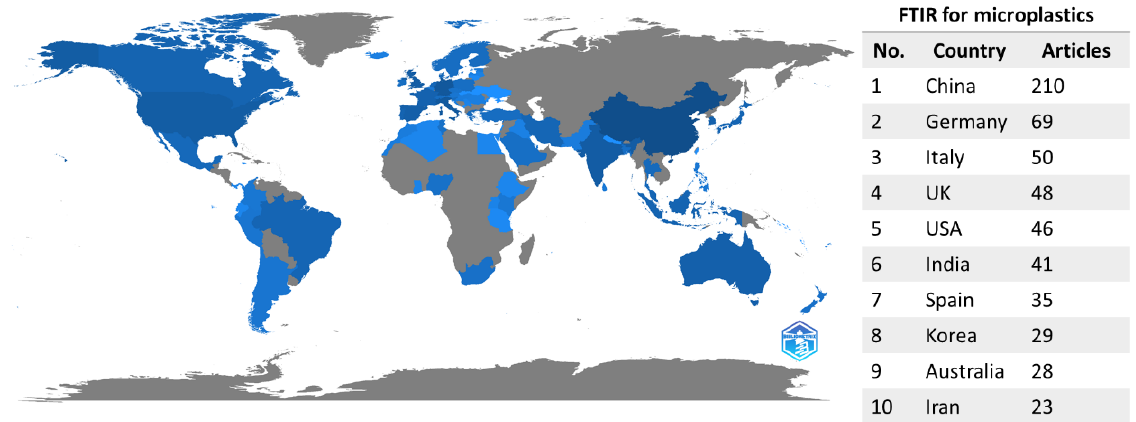
Figure 3. Scientific production by country-FTIR related Literature. The map was generated using the open-source tool Biblioshiny for Bibliometrix [38]. Different shades of blue indicate different productivity rate: dark blue = high productivity; grey = no articles. Number of documents is listed per corresponding author’s countries.